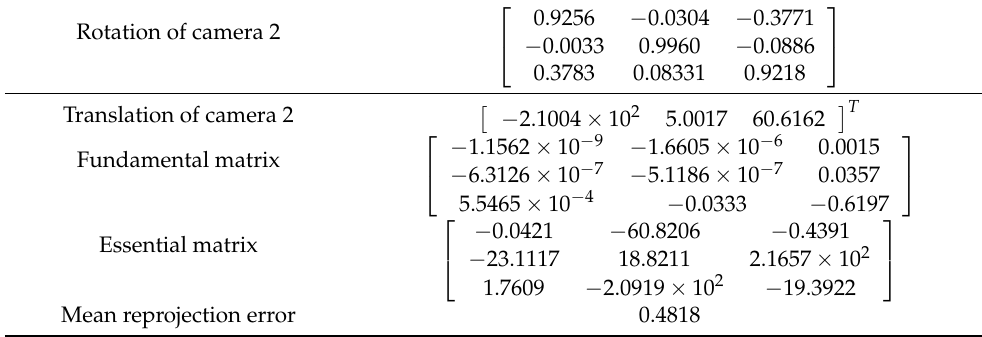
Table 3. External parameters of the vision system obtained during calibration in the Matlab environ-